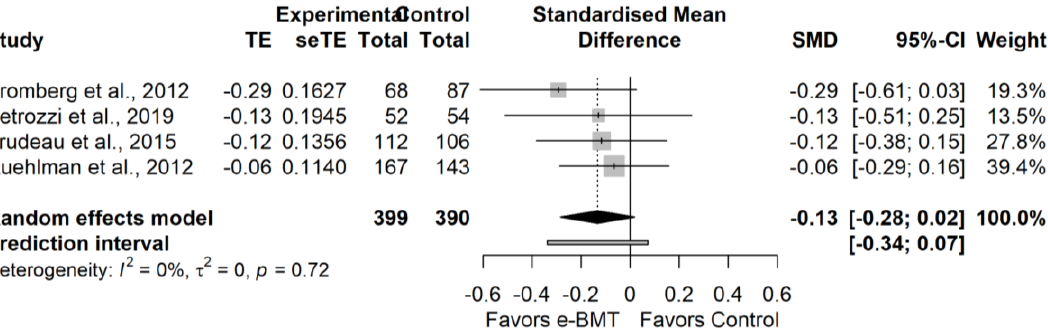
Figure A23. Forest plot of the studies included in the sensitivity analysis and the studies filled to adjust for publication bias The trim and fill method did not add any study.